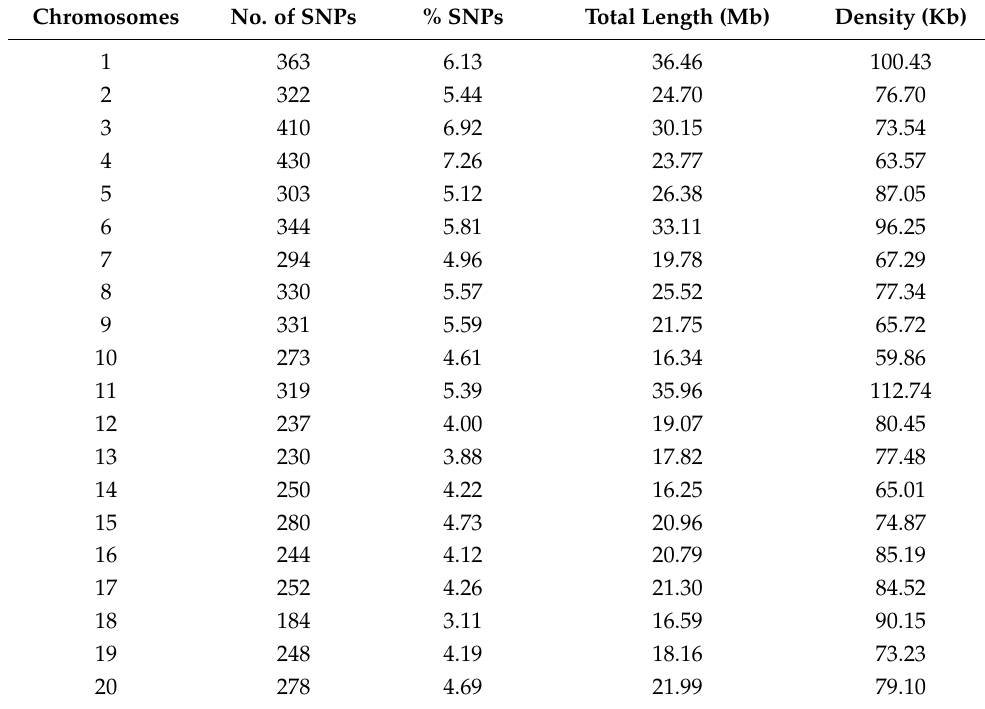
Table 1. Genomic distribution of 5922 SNPs across 20 chromosomes of L. mutabilis .